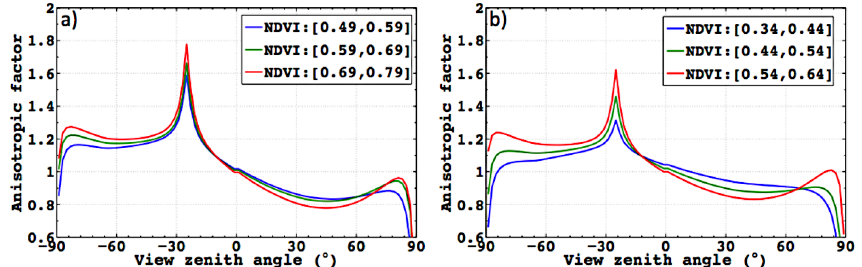
Figure 6. CERES SW anisotropic factors in the principal plane for a region centered at 6.5 ◦ S and − 59.5 ◦ W for (a) July and (b) September for θ 0 = 24 ◦ for all available NDVI bins. Anisotropic factors are derived based upon 60 months of CERES Terra measurements over clear CERES